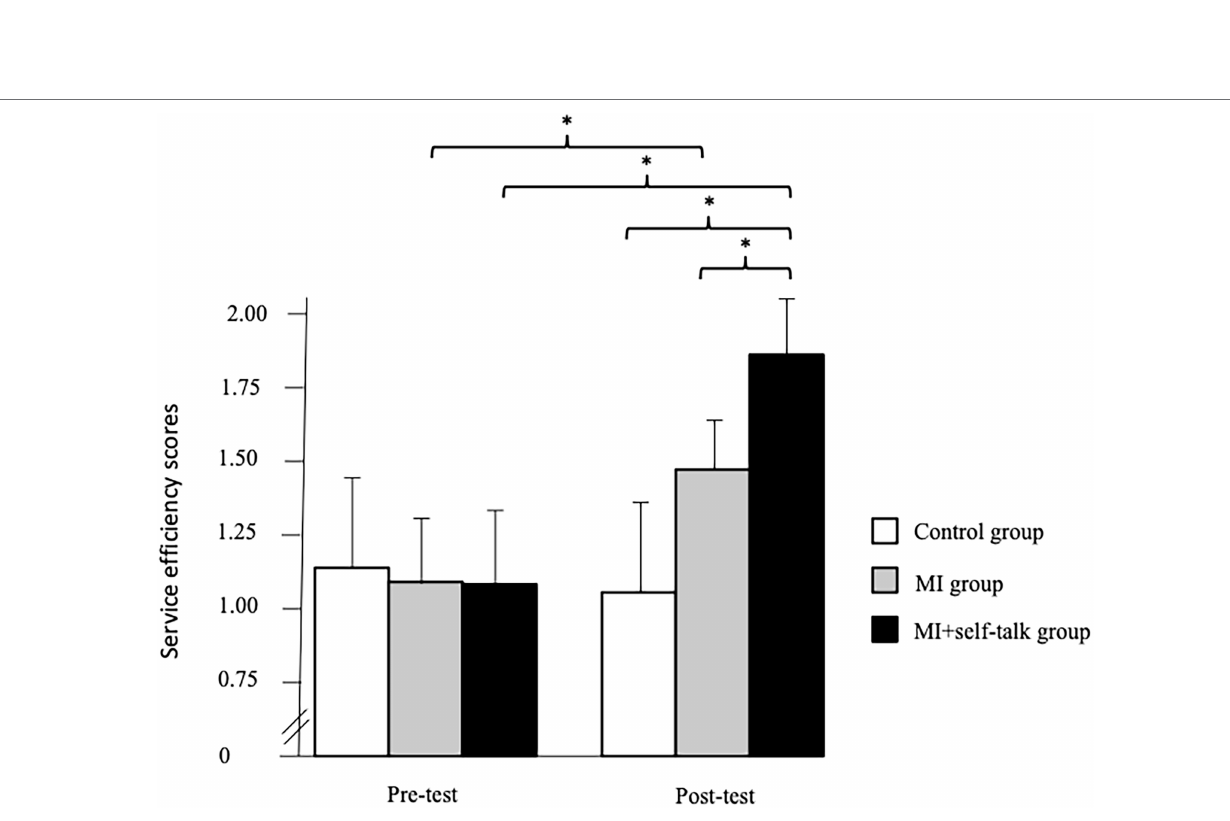
FIGURE 2 | Significant interaction between the group and the phase (* p < 0.01) concerning the service efficiency scores. Motor imagery